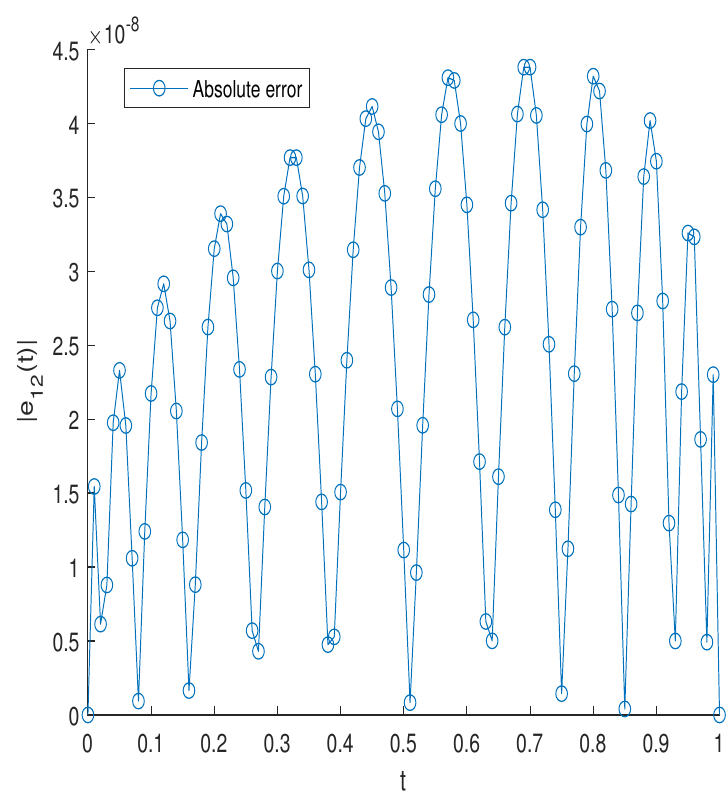
Figure 9. The graph of the absolute error for Example 4 and N =